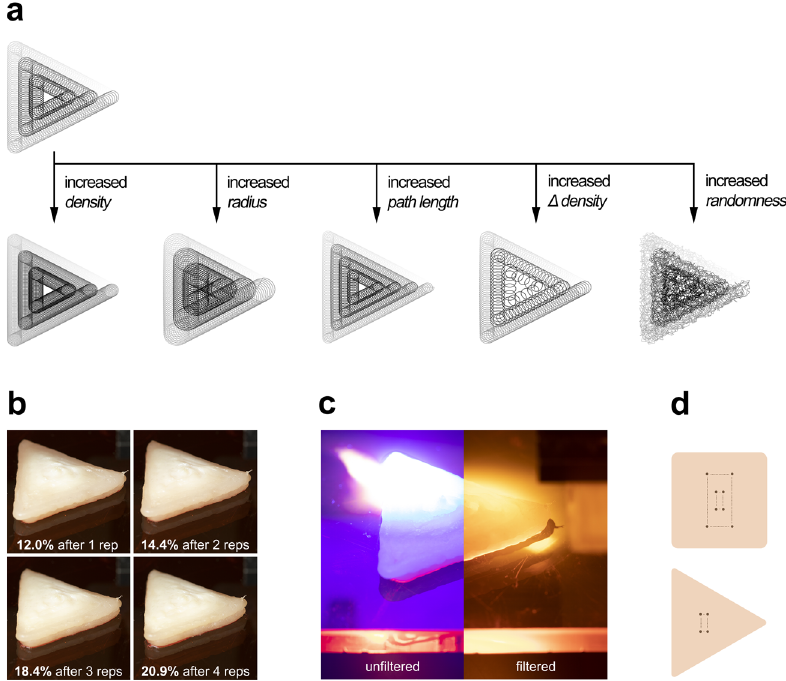
Fig. 2 Laser cooking pattern and temperature sensing. a Foundational laser cooking pattern used during testing showing variations that were made to alter cooking results. Illustration is in the form of a triangle, but the perimeter can take the shape of any closed contour. b Shrinkage (%) of two-layer printed chicken sample documented after each repetition of the cooking pattern with the blue laser. c Un fi ltered and fi ltered images of chicken being laser-cooked. d Eight thermocouples were placed for square prints (top) and four thermocouples were used for triangular prints